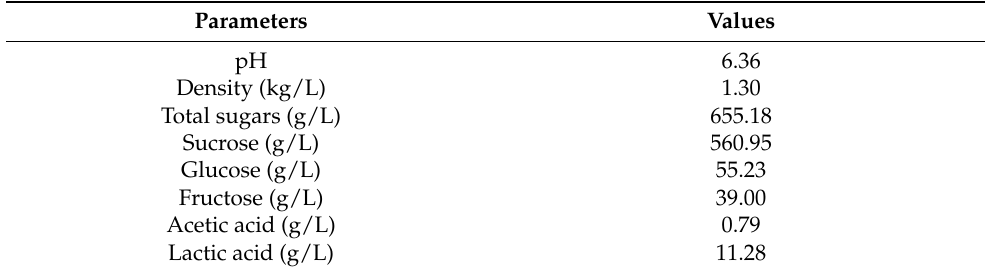
Table 1. Chemical and physical properties of the raw sugar beet molasses used for the RSM fermen- tation